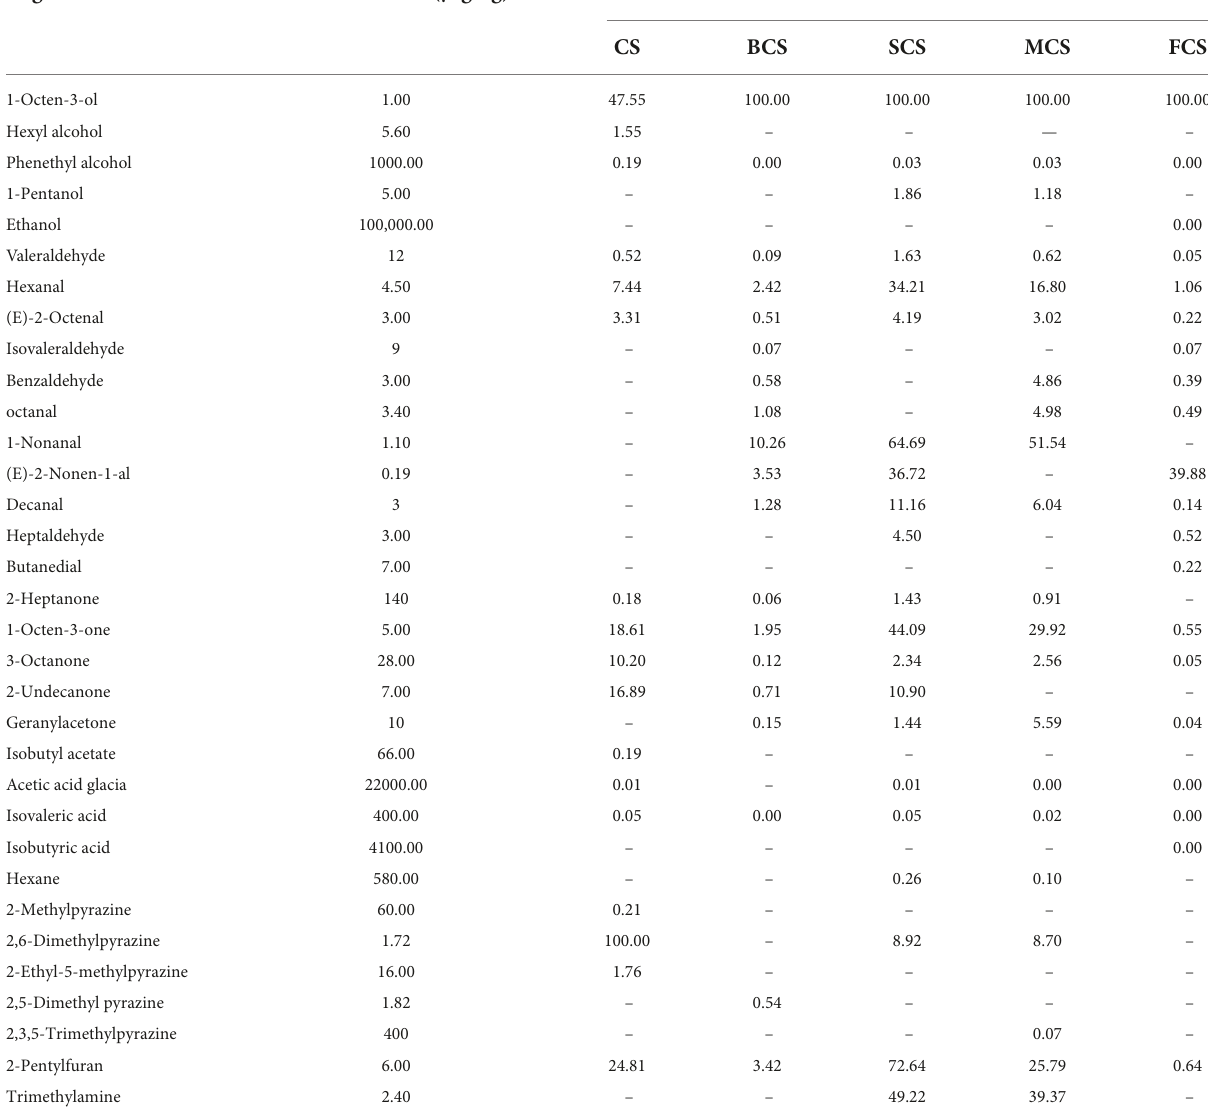
TABLE 2 Key volatile compounds in C. squamulosa with different cooking